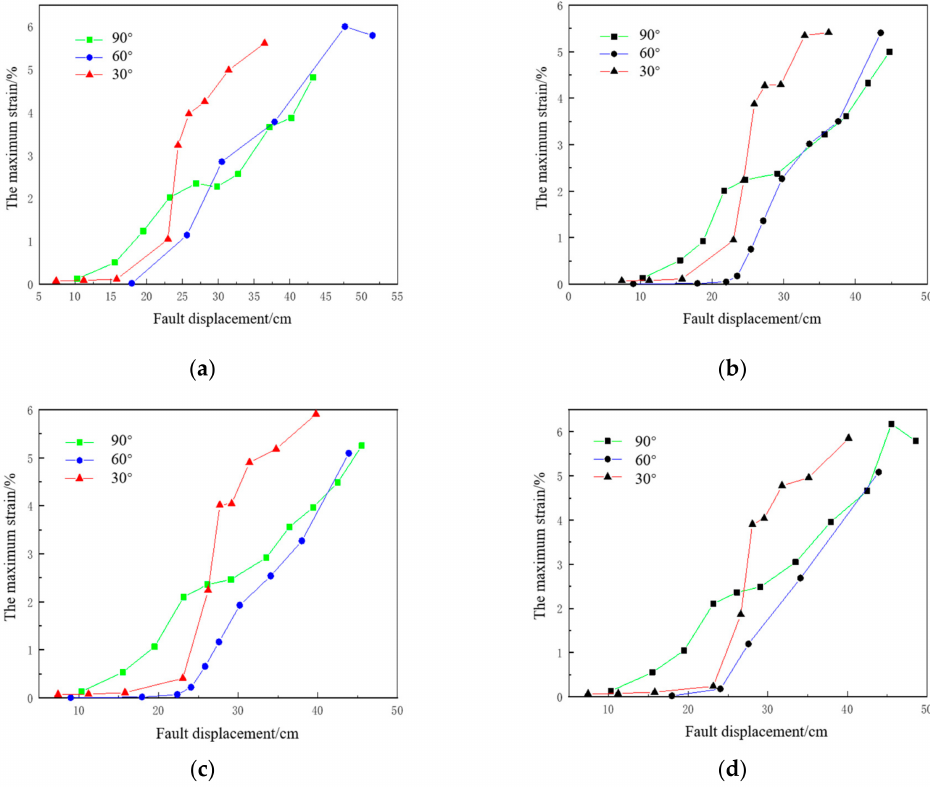
Figure 17. The maximum strain change law of pipeline under different included angles: ( a ) 168.3 × 4.5; ( b ) 168.3 × 5.0; ( c ) 168.3 × 5.5; ( d ) 168.3 ×